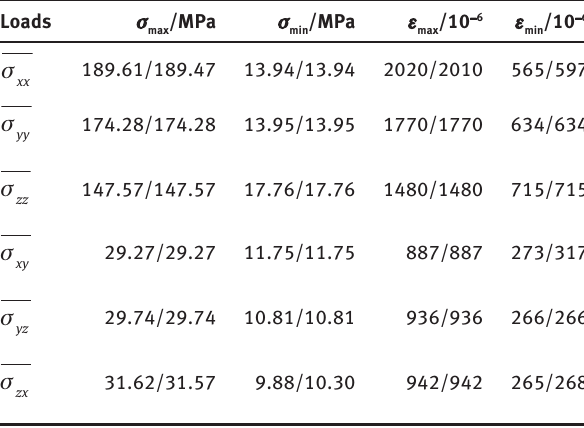
Table 8: The influence of Z